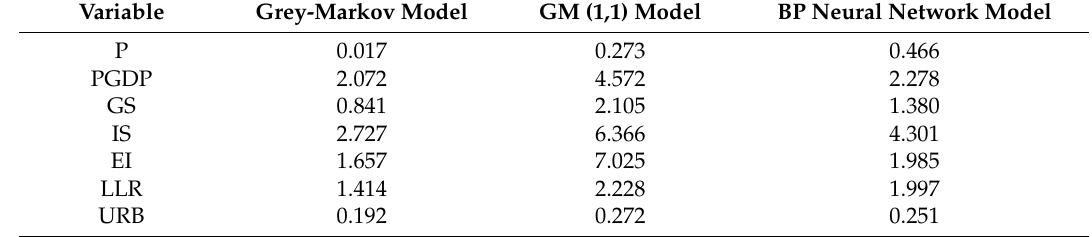
Figure 8. The forecasting results for urbanization level. Table 7. The MAPE values of forecasting results for the driving factors.